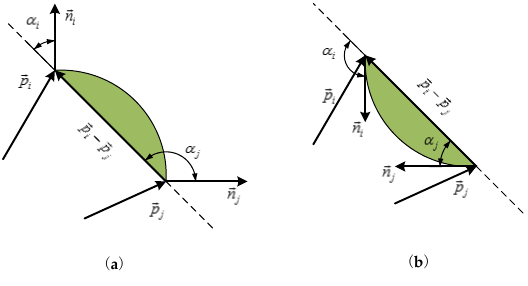
Figure 3. The concave and convex criterion: ( a ) the convex surface; ( b ) the concave